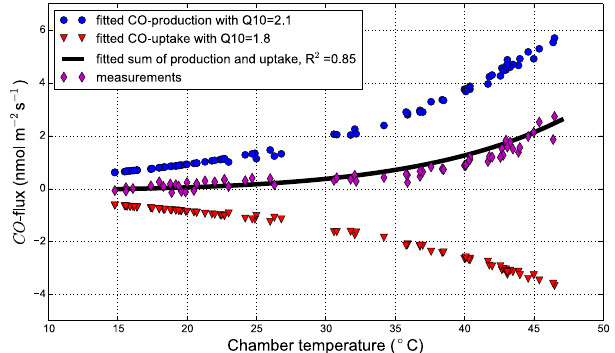
Figure 5. Fitted CO fluxes for 15–19 August (black line) for mea- sured field CO fluxes (purple diamonds)( R 2 = 0 . 85). The cumula- tive fitted CO flux is a sum of fitted CO uptake (with Q 10 = 1.8, based on literature (Whalen and Reeburgh, 2001) and fitted CO production (with Q 10 = 2.1) based on chamber temperature (after 6min closure).